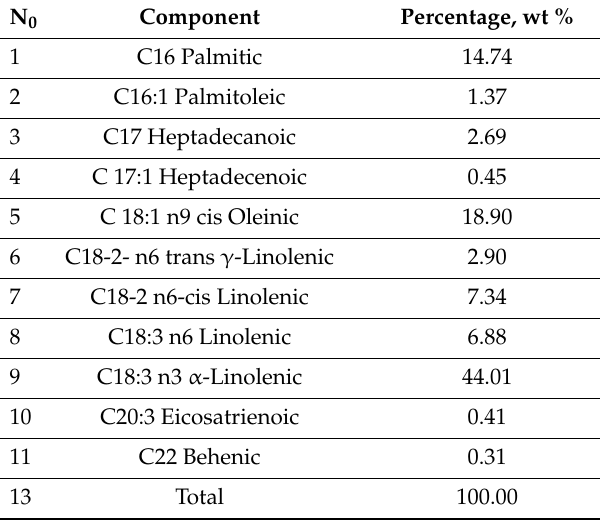
Table 2. Fatty acid composition of lipids derived from C. sorokiniana